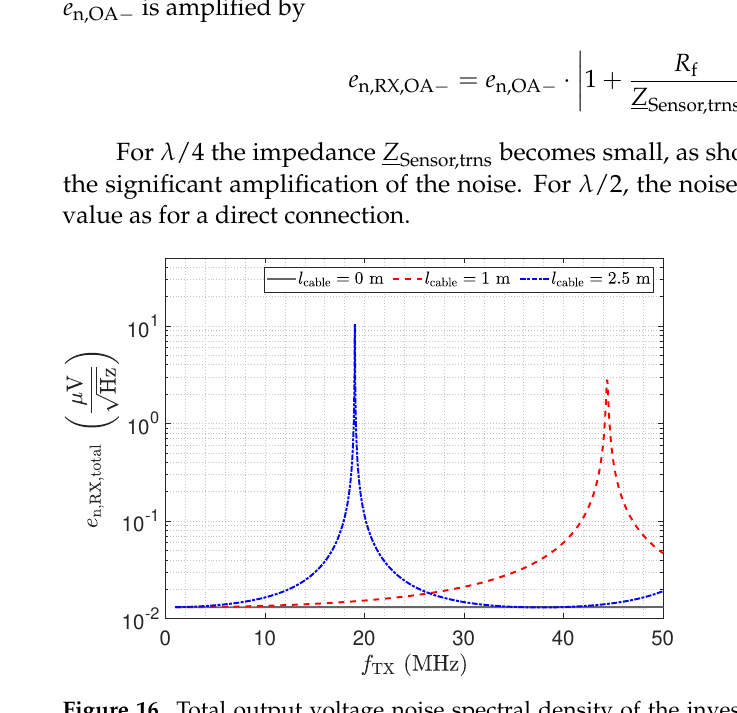
Figure 16. Total output voltage noise spectral density of the investigated low-Z circuit for three different transmission line lengths. The SPICE based simulation includes the capacitive Π network.